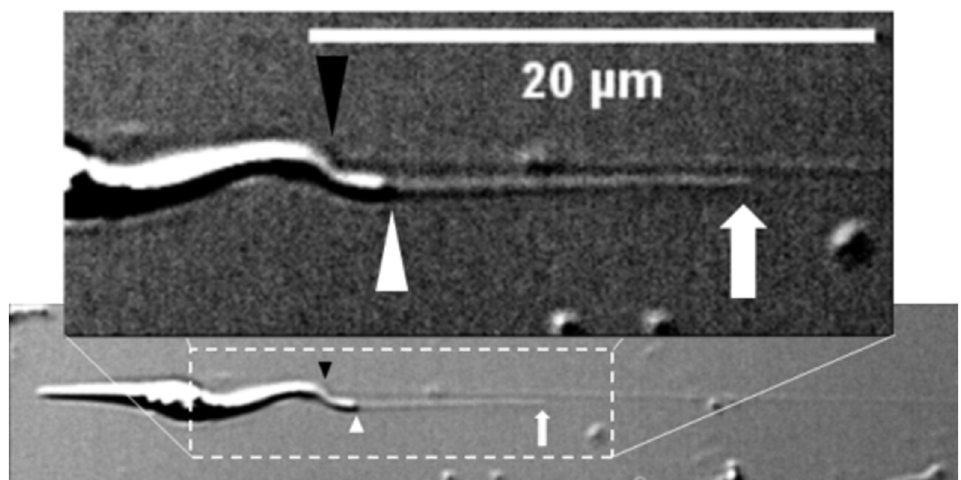
Fig 6. Doubly tethered epimastigote at 90x magnification. Inset is a 3X digital magnification of the delimited area. The first filament (on the right) emerged at a shear stress of 1.55 pN/ μ m 2 from an anchoring point established over 100 μ m away from the tip of the flagellum (see S4 Fig); During extension, a second anchoring point was established (white arrow), from which the second filament emerged; both extended until the point marked with the black arrowhead for the first filament and the white arrowhead for the second filament, both near the tip of the flagellum.